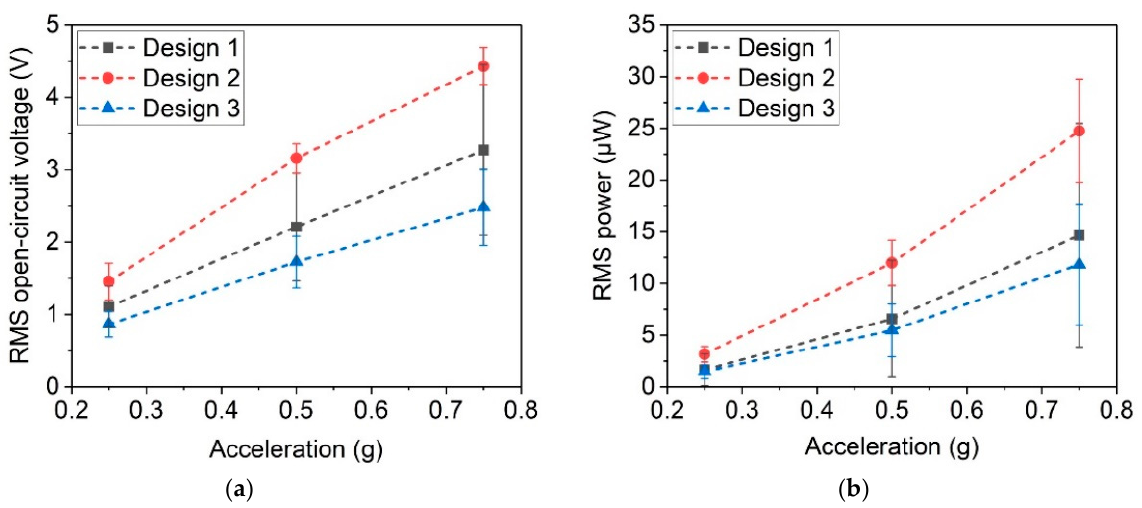
Figure 19. ( a ) Open-circuit voltage and ( b ) power output at optimal resistance for the different harvester designs in resonance for accelerations of 0.25 g, 0.5 g and 0.75 g.